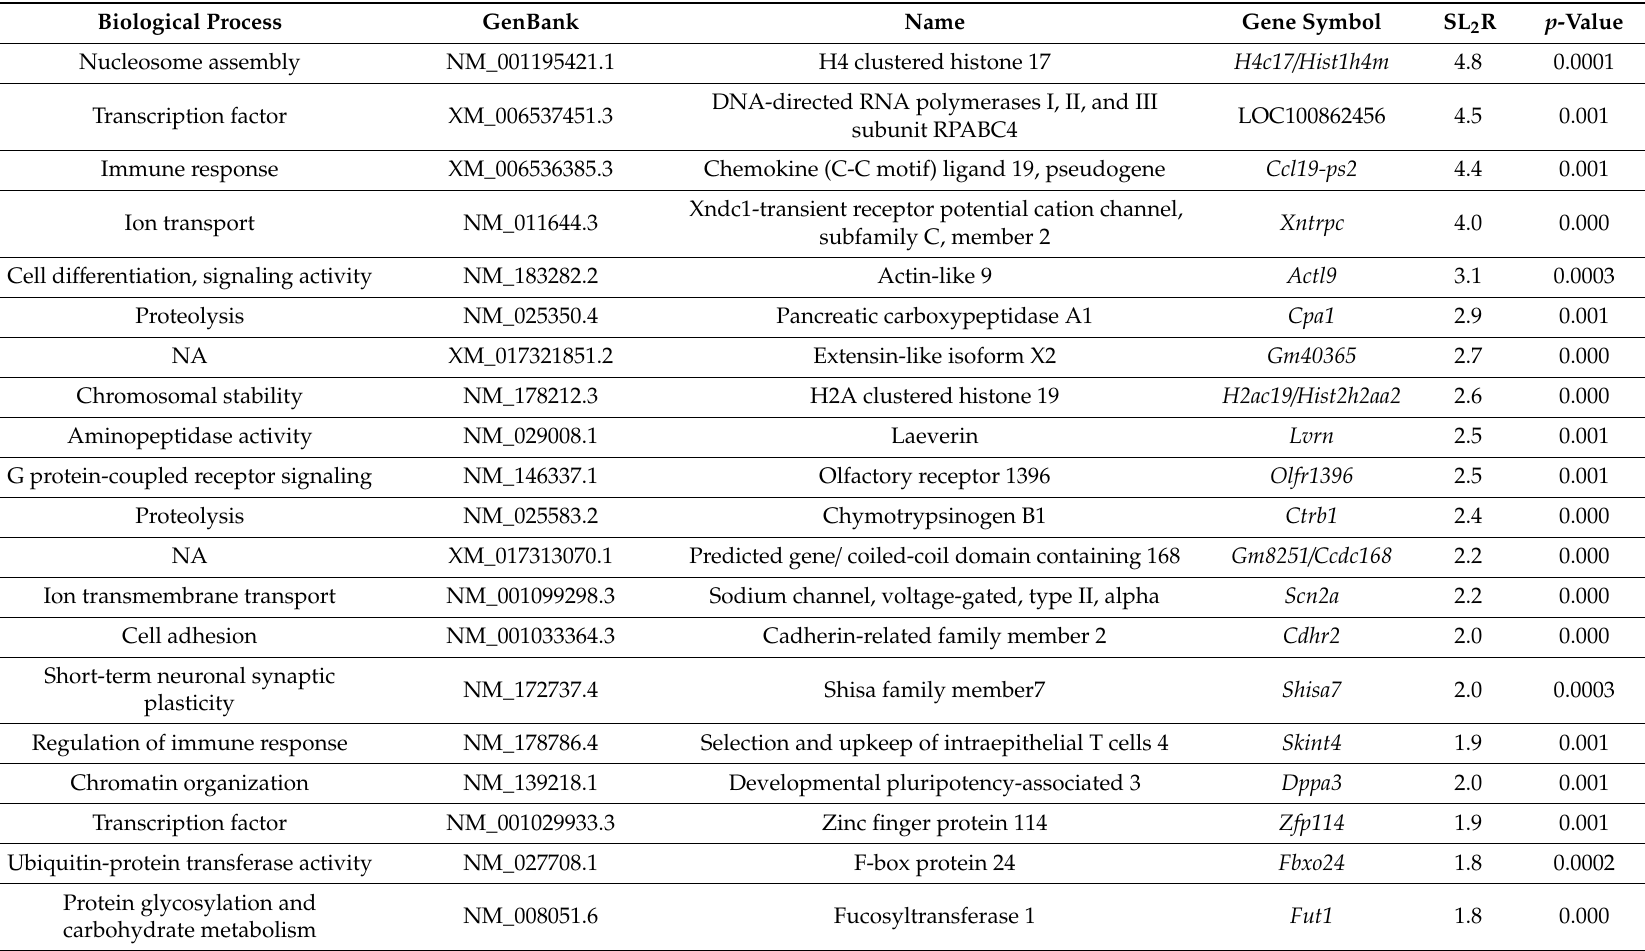
Table 1. Hepatic transcripts di ff erentially up-regulated by the administration of erythrodiol at the level of signal log 2 ratio (SL 2 R) > 1.5 and false discovery rate < 0.001 in male Apoe-deficient mice according to